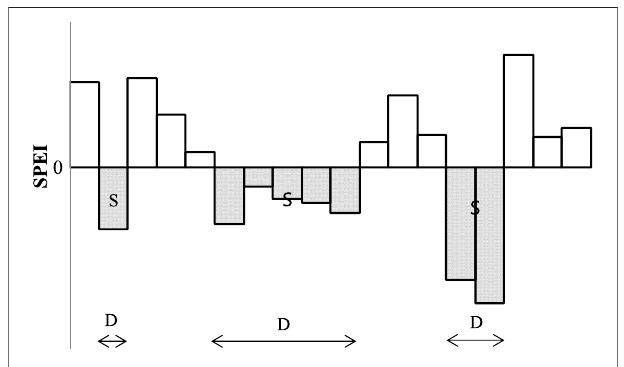
FIGURE 2 | Diagram of duration and severity of